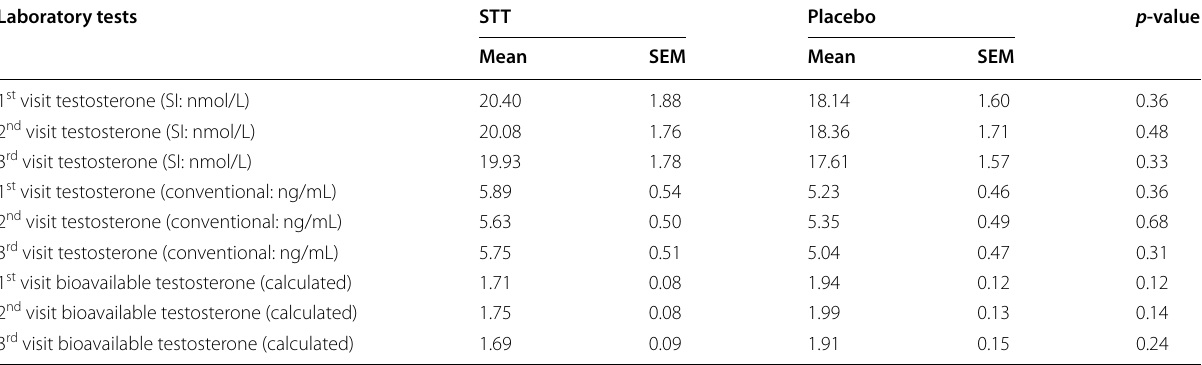
Table 3 Mean, standard error of the mean (SEM), and p-value for the effect of treatment on testosterone levels between the STT and placebo